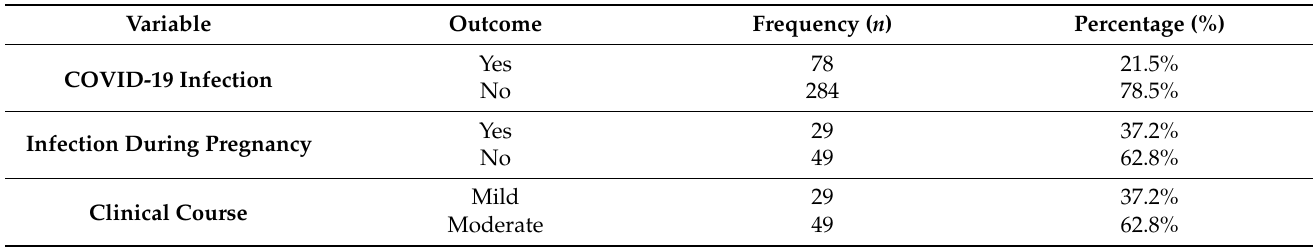
Table 3. COVID-19-related anamnesis of pregnant and lactating women (PLW), University Hospital Brno, August–October 2021 ( n = 362).